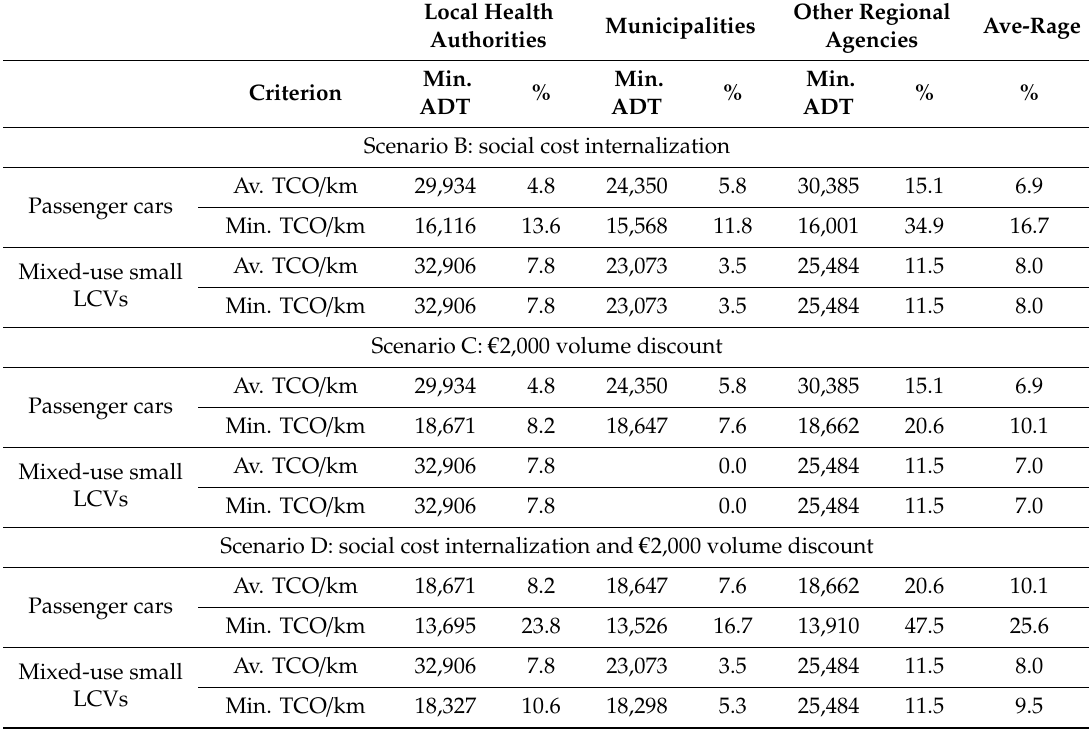
Table 8. Percentage of passenger cars and mixed-use small LCVs that if BEVs would have a lower TCO /